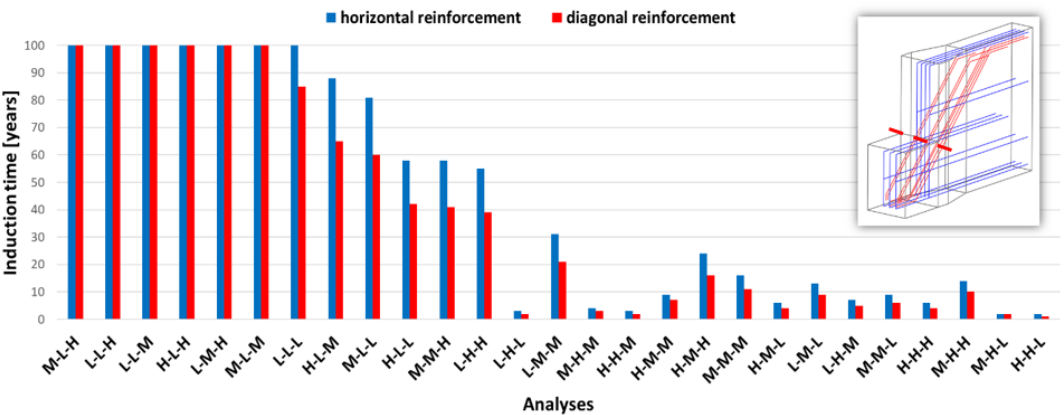
Figure 16. Induction time as a function of the chloride parameter combination.